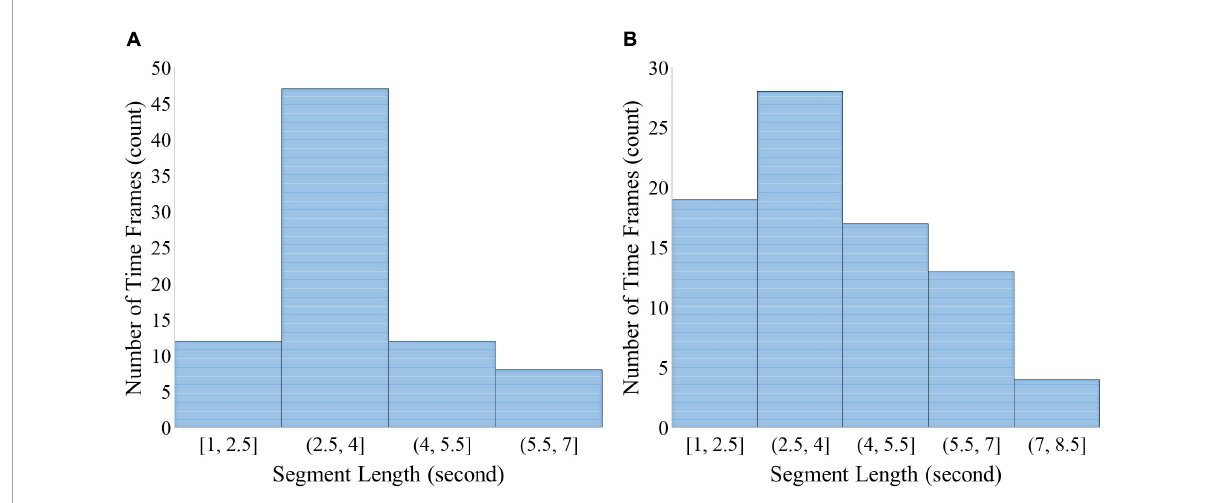
FIGURE4 Segment length analysis in (A) multimedia 1 and (B) multimedia 2. Histograms show the frequency of number of meaningful timeframes regarding segment length for multimedia 1 (A) and multimedia 2 (B) .